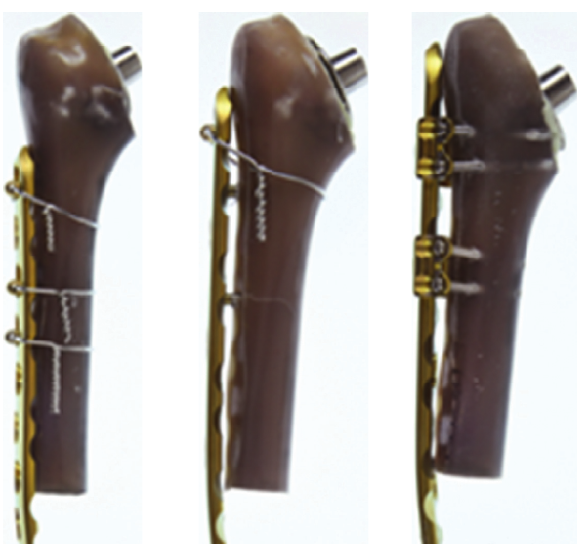
Figure 2: Humerus-LCP construct after performing the transverse osteotomy 5 cm distal to the end of the prosthesis, with the irreversibly bent LCP after performing the biomechanical stability testing.